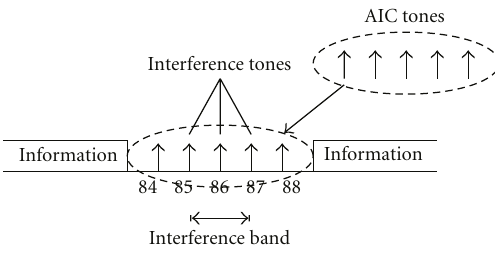
Figure 1: Interference band, interference tones, and AIC tones. The computed AIC tones replace the interference tones and the two tones beside